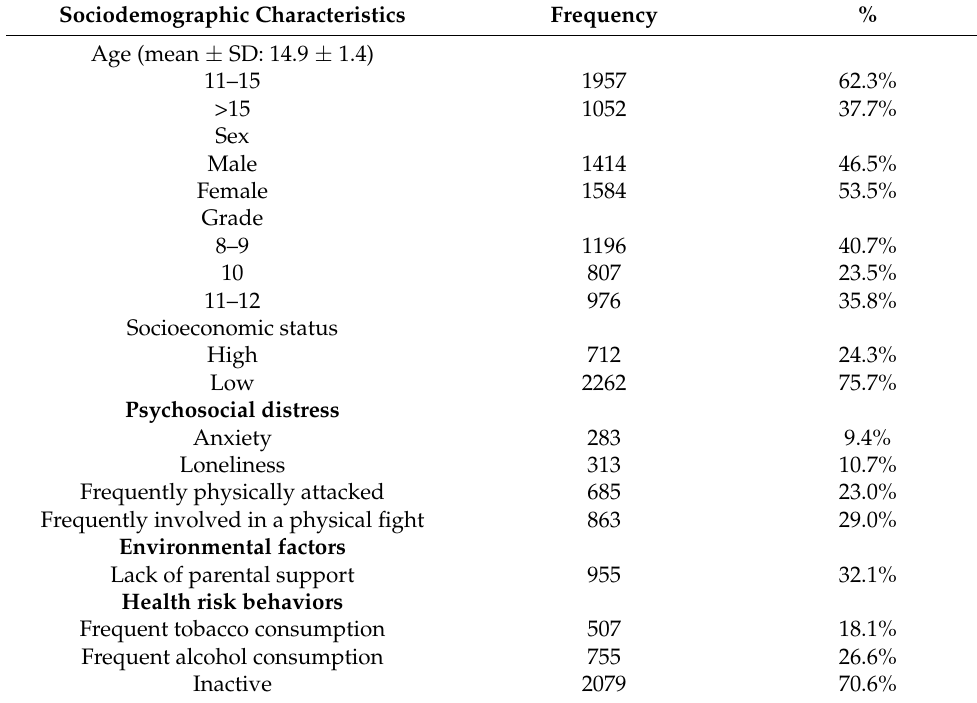
Table 1. Sociodemographic and behavioral characteristics of adolescents aged 11–18 in Mauritius,